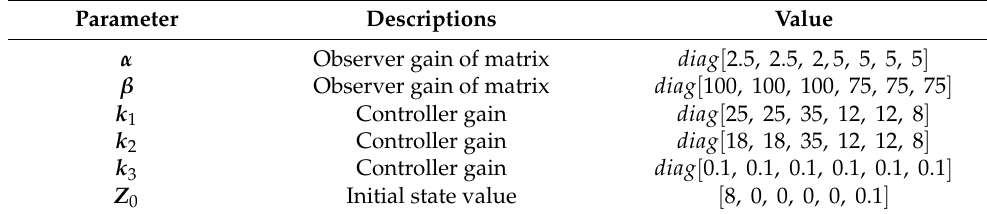
Table 2. Controller parameters for